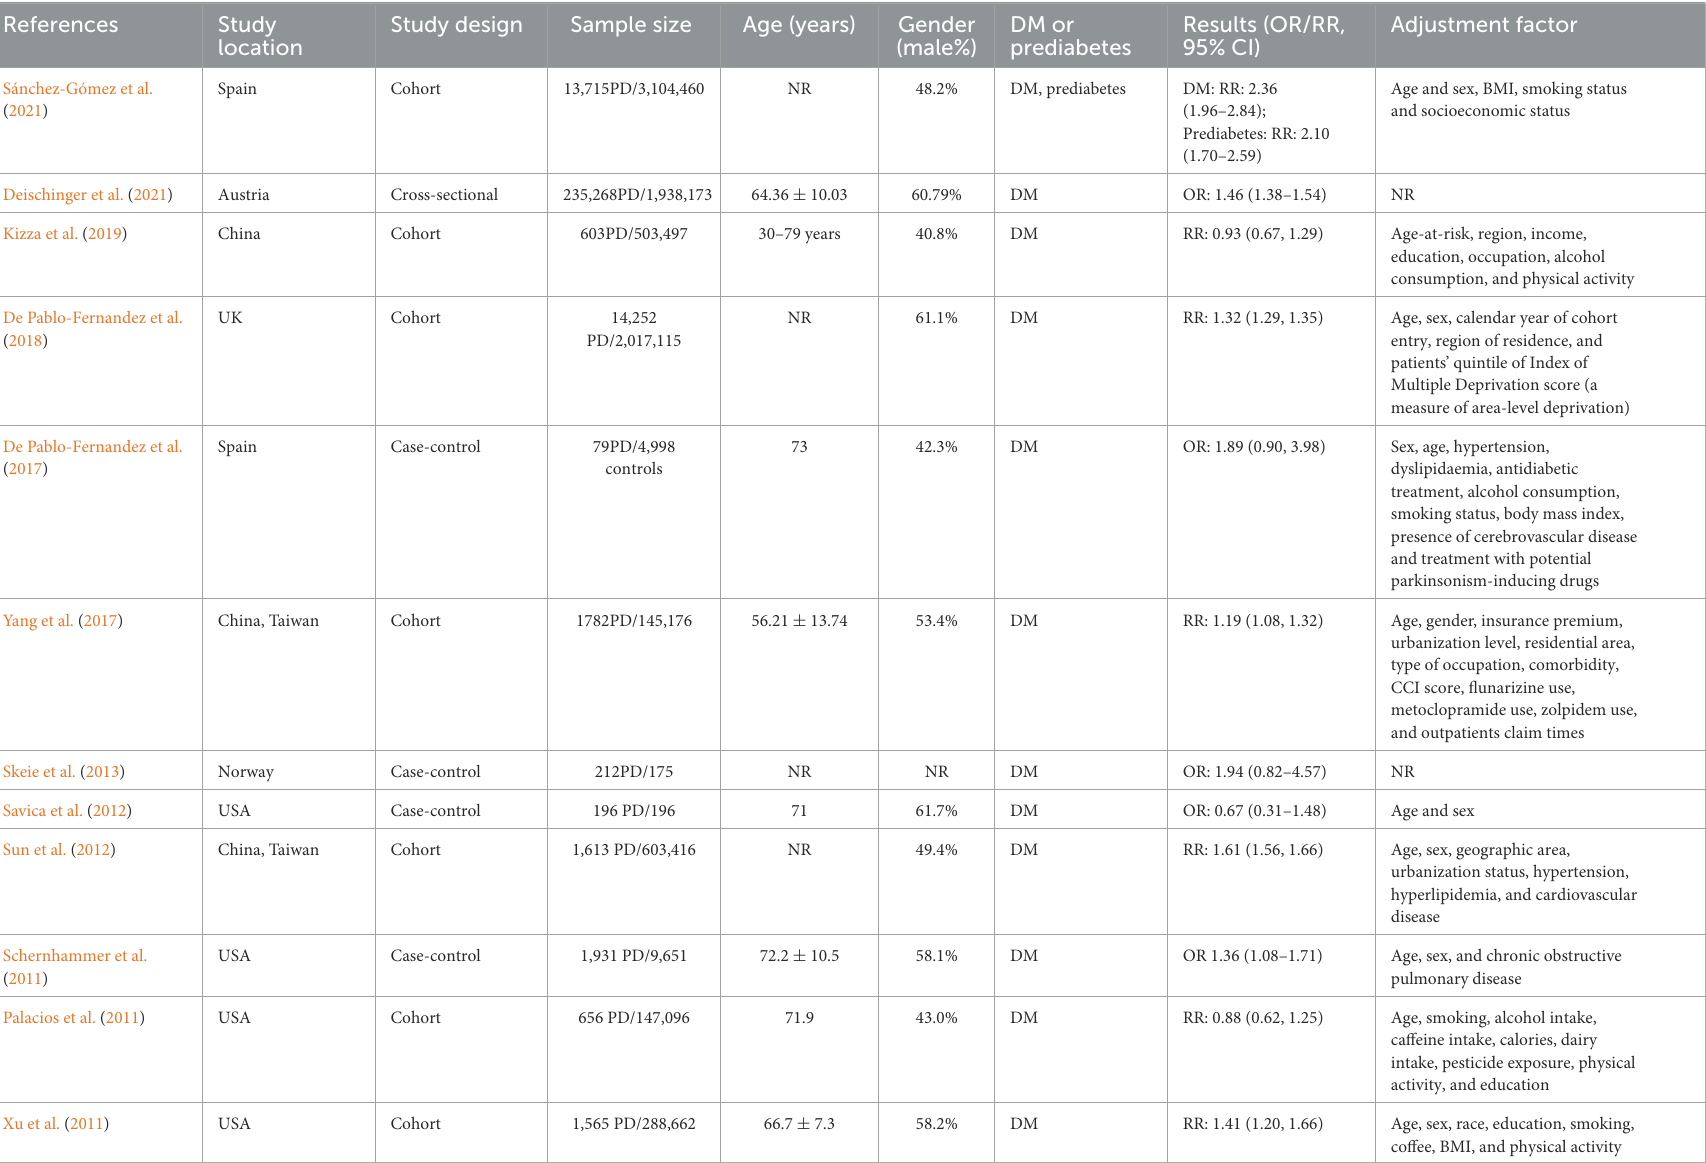
TABLE 1 Characteristics of included studies exploring association between DM, prediabetes and risk of